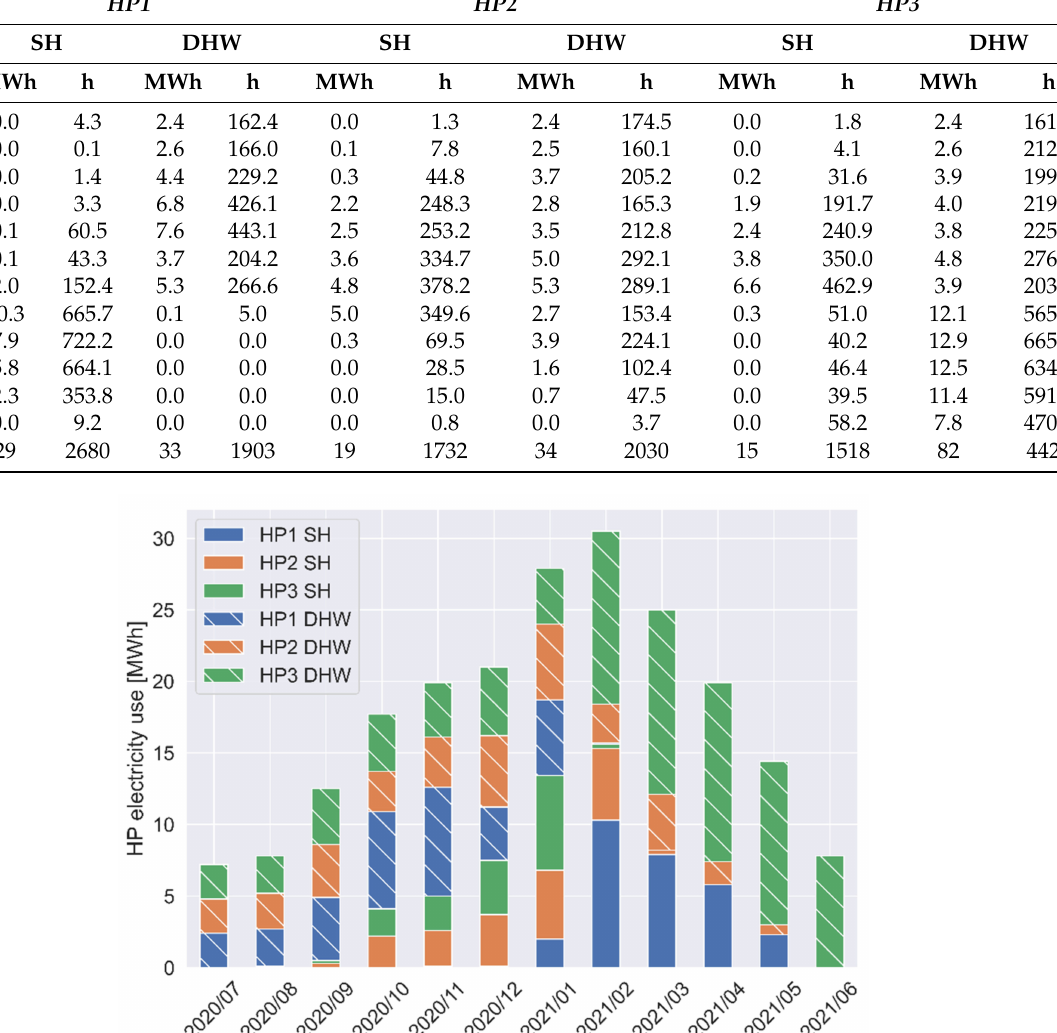
Table 4. Heat pumps: monthly electricity use and operation time in SH and DHW modes. HP1 HP2 HP3